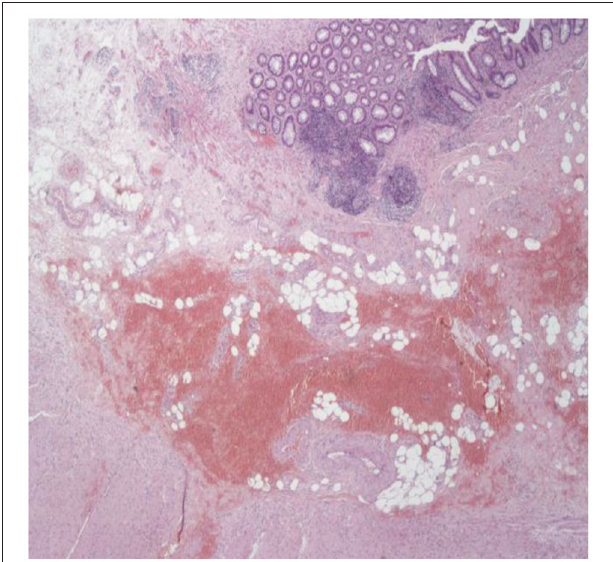
FIGURE 2 | Intramural bleeding in the submucosa of a specimen.